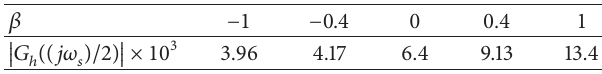
Table 1: FROH’s amplitude of the frequency responses for different values of 𝛽 at 𝜔 = 𝜔 𝑠 /2 .